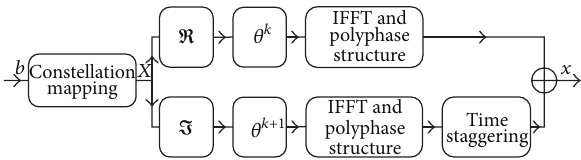
Figure 1: Block diagram of FBMC